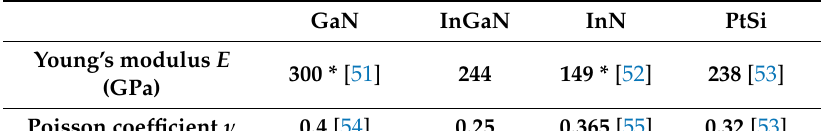
Table 2. Material settings used for the calculations (* refer to bulk values).